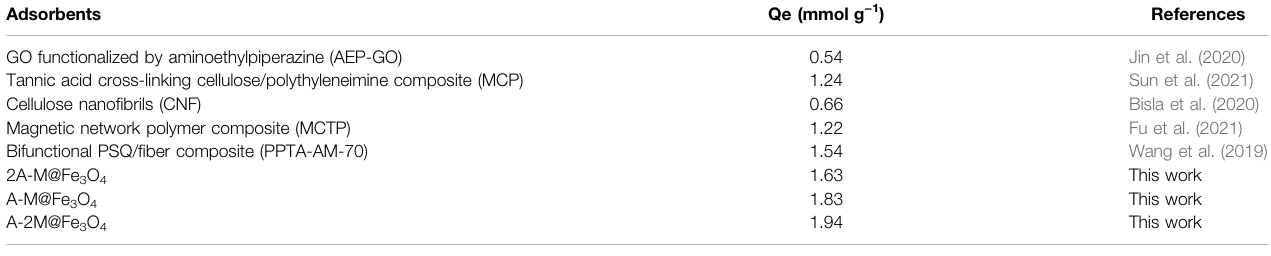
TABLE 4 | The adsorption capacity comparison of different adsorbents for Hg(II) at 25 ° C. Adsorbents